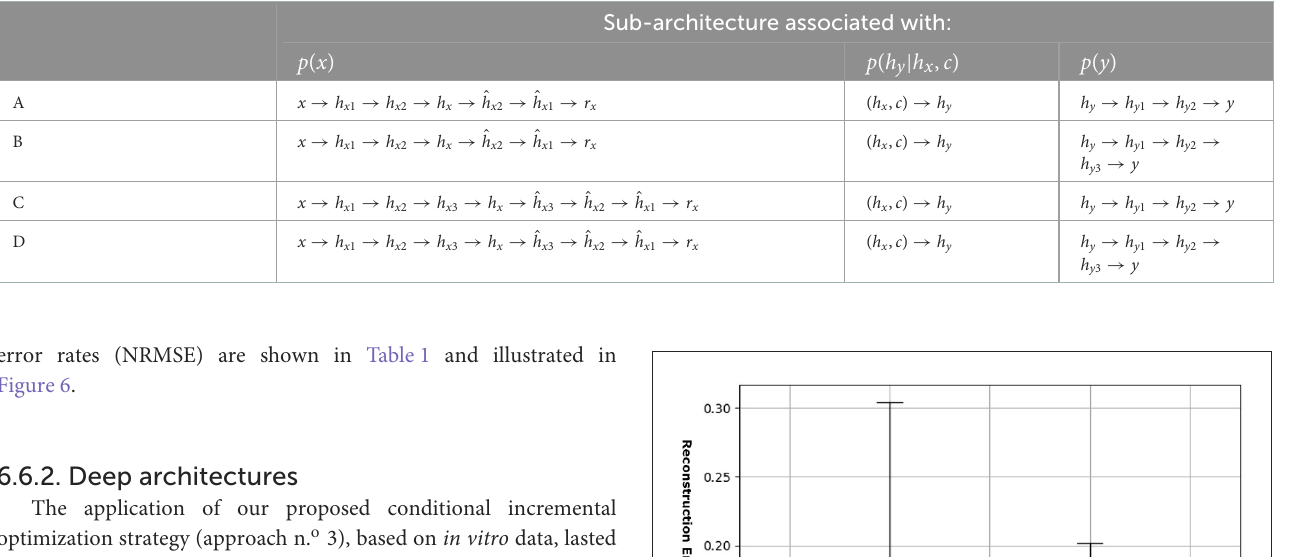
TABLE 2 DCAE architectures obtained by approach n. o 3 on the in vitro database.